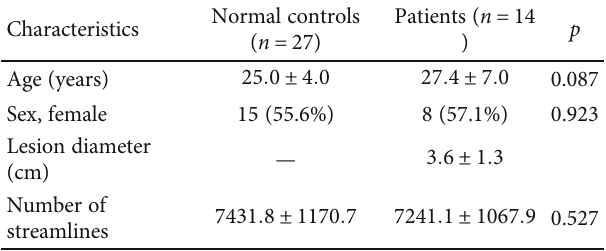
Table 2: Basic characteristics of normal controls and patients.